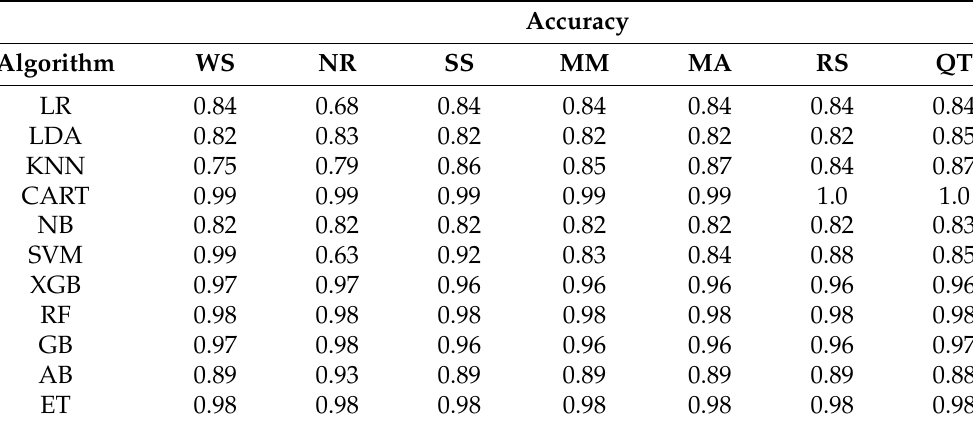
Table 5. Overall performance of different algorithms based on